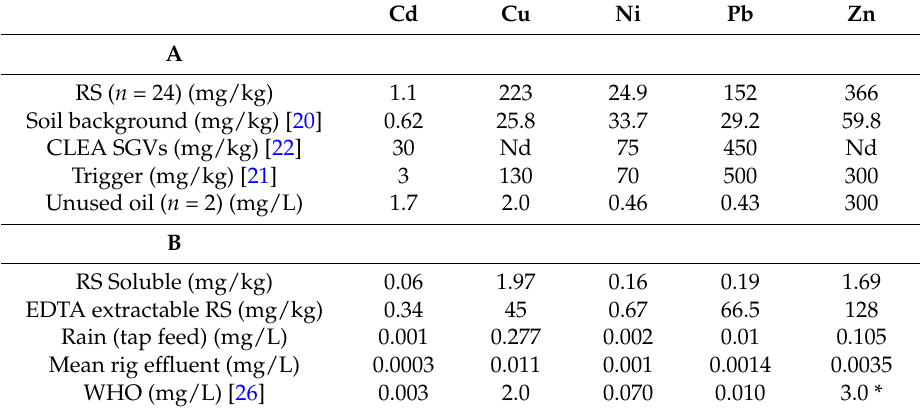
Table 1. ( A ) Total concentrations of heavy metals in RS compared with published background and guideline values of heavy metals in unused oil (mg/L); ( B ) Average concentrations of heavy metals in test pollutants materials and artificial rainfall (tap water